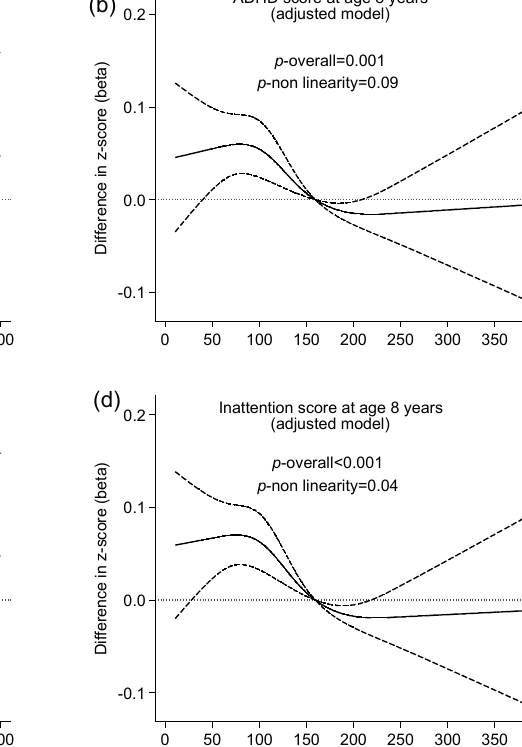
Figure 2. Association between maternal iodine intake from food and proportional risk of child ADHD diagnosis. Results are from multivariable regression analysis and are restricted to non-users of iodine supplements during first half of pregnancy ( n = 53,360 mother–child pairs). Iodine intake was modelled by restricted cubic splines (four knots), and the reference level was set to 160 µg/day. Dashed lines represent 95% confidence limits. The histogram ( b ) illustrates the distribution of iodine intake. Both models ( a , b ) were adjusted for random effects of sibling clusters and for energy intake to control for measurement error. The adjusted model ( b ) was additionally adjusted for maternal age, BMI, parity, education, smoking in pregnancy, and fiber intake. The vertical axis on hazard ratios are on the log scale. ADHD: attention-deficit/hyperactivity disorder.